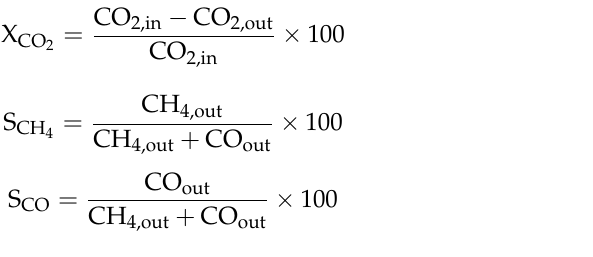
lysts; Figure S2. N 2 adsorption isotherm of Sm 2 O 3 and 10Ni/Sm 2 O 3 catalysts; Figure S3. Infrared transmittance spectra of Sm 2 O 3 and 10Ni/Sm 2 O 3 catalysts; Figure S4. Ru3d XPS spectrum of Ru-Ni/Sm 2 O 3 catalyst. Figure S5. The methanation reaction over 10Ni/Sm 2 O 3 at 3-different temper- ature for 1h at each 250 ◦ C, 300 ◦ C and 350 ◦ C. Supporting Information S6. The detail description of instrument and characterization